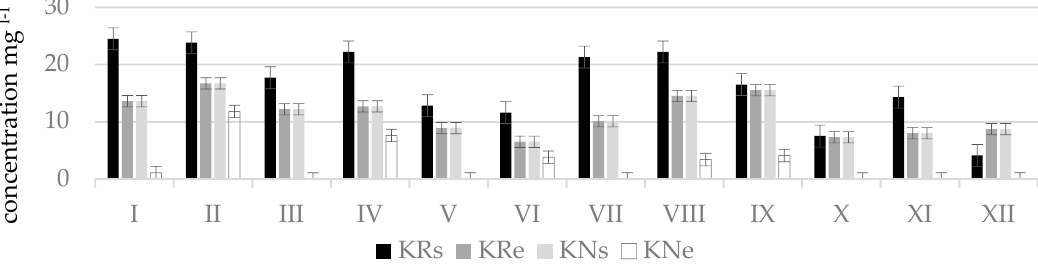
− ) in natural (N) and regulated (R) stretches of Kuosin˙e stream. Figure 5. Nitrate concentrations ( NO (cid:2871)(cid:2879) ) in natural (N) and regulated (R) stretches of Kuosin ė stream. Figure 5. Nitrate concentrations (NO 3 Figure 5. Nitrate concentrations ( NO (cid:2871)(cid:2879) ) in natural (N) and regulated (R) stretches of Kuosin ė stream. Figure 5. Nitrate concentrations ( NO (cid:2871)(cid:2879) ) in natural (N) and regulated (R) stretches of Kuosin ė stream. exceeded the limit value for good ecological status (phosphate concentrations 0.28 mg PO 3